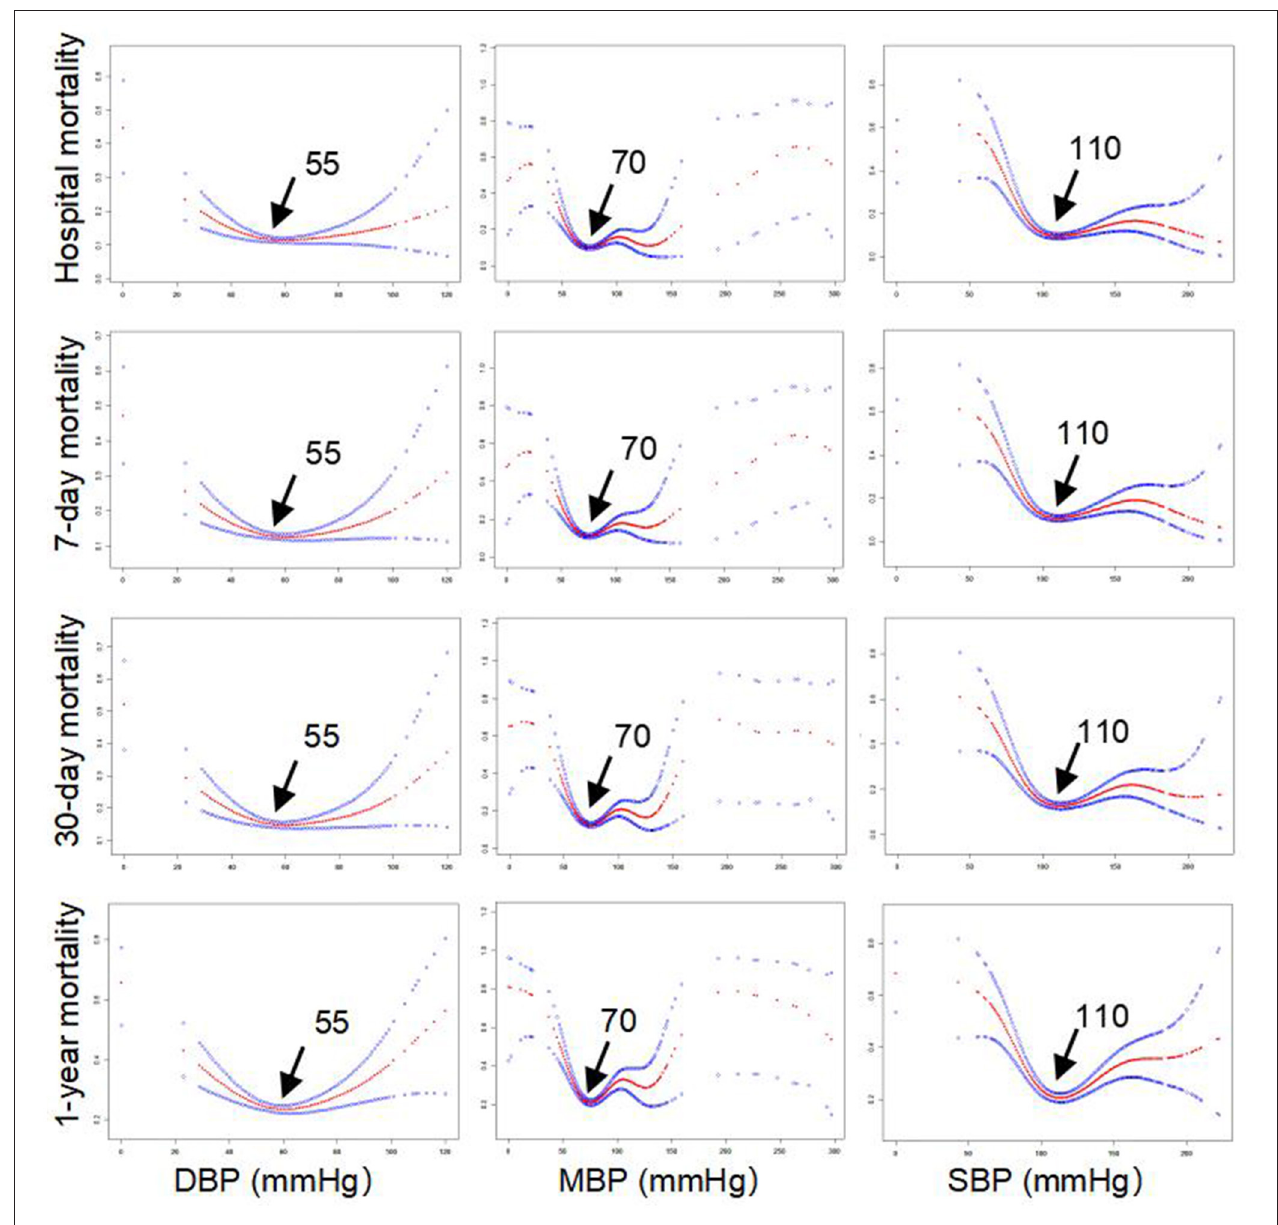
FIGURE 1 | Smooth curve analysis of the association between blood pressure (BP) and